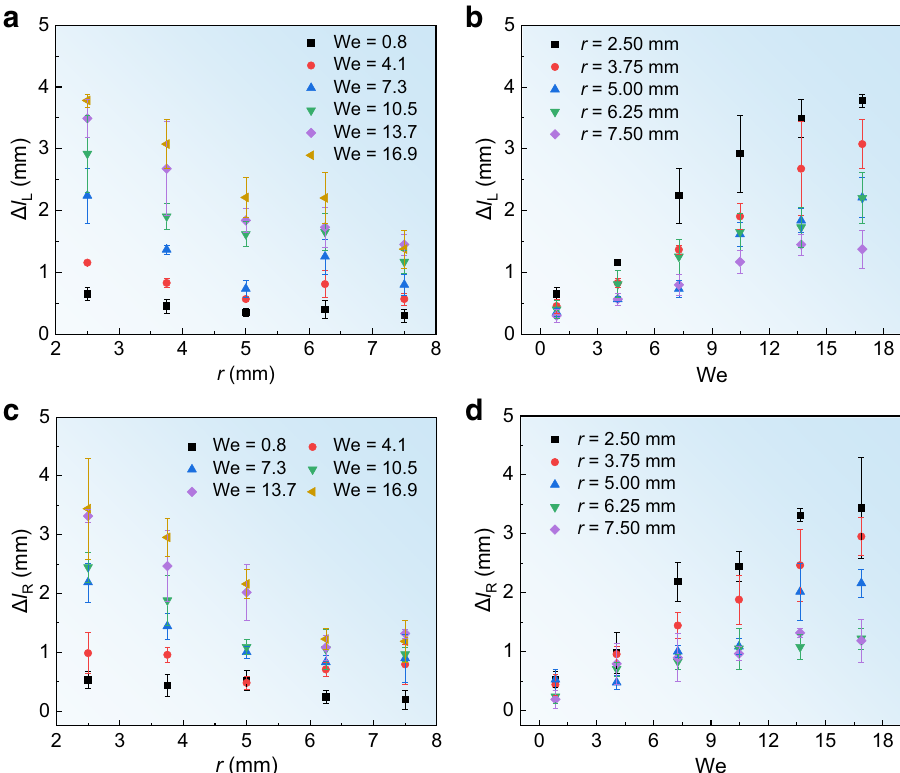
Fig. 3 Lateral displacement Δ l as functions of r and We at different temperatures. a , b Variation of Δ l L at T = 250 °C as a function of r under various We and as a function of We for various r , respectively. c , d Variation of Δ l R at T = 350 °C as a function of r under various We and as a function of We for various r , respectively. The error bars of the data in a – d denote the standard deviation of three measurements. Source data are provided as a Source Data fi